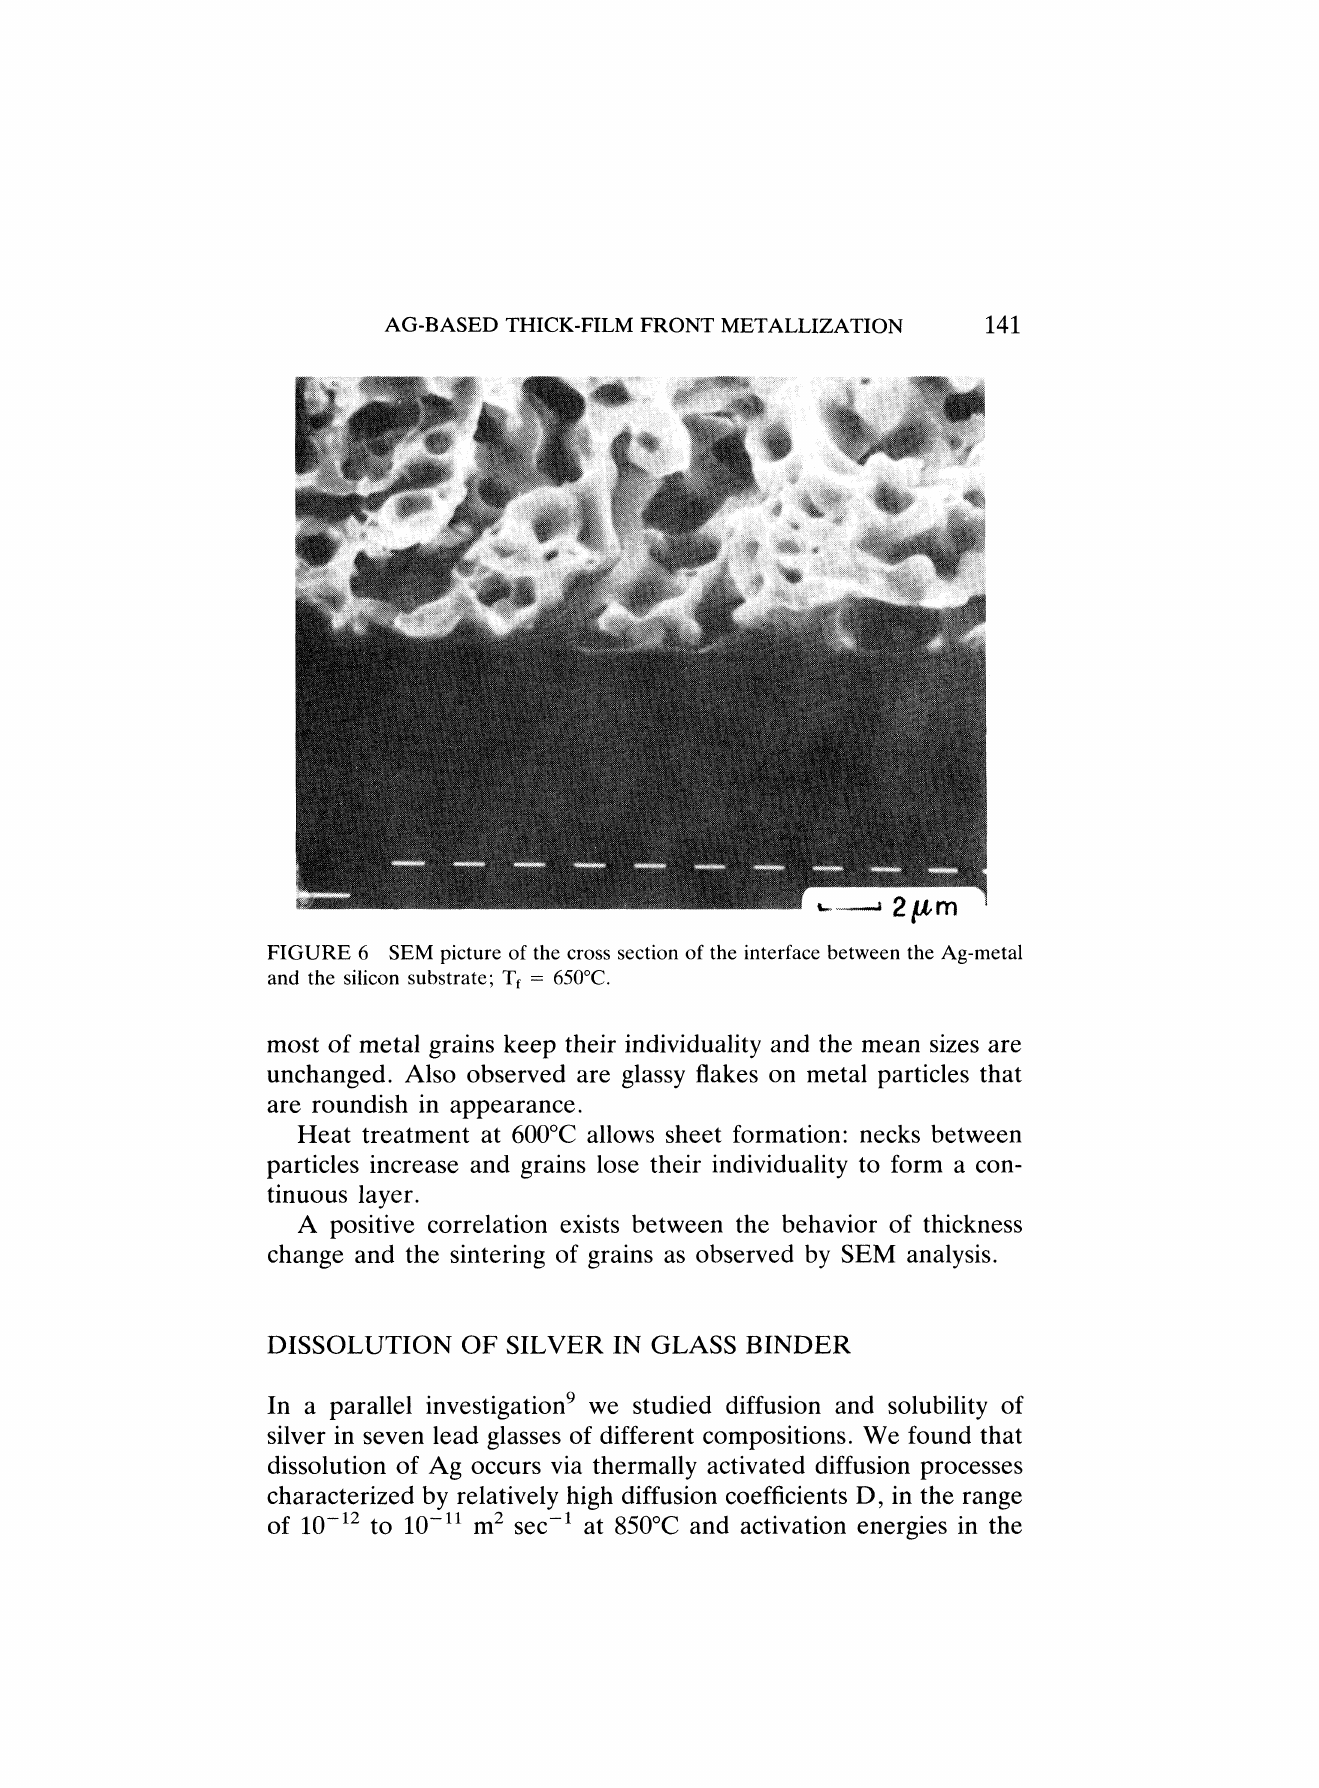
FIGURE 6 SEM picture of the cross section of the interface between the Ag-metal and the silicon substrate; Tf